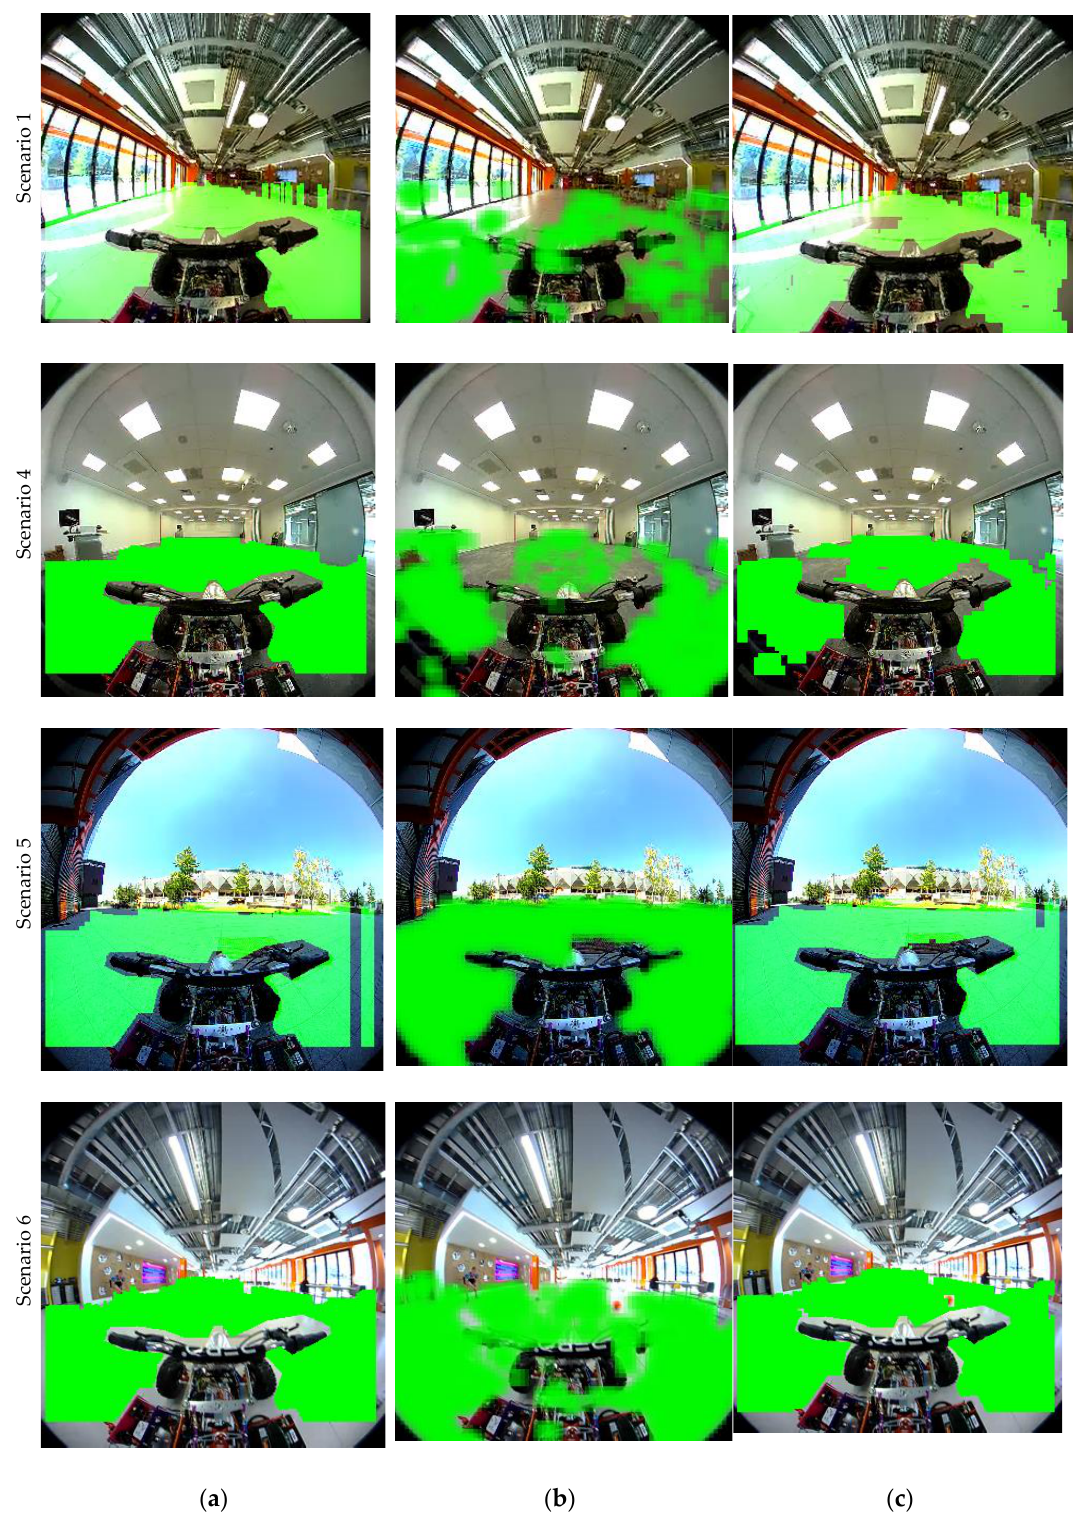
Figure 11. Comparison of free-space maps for different algorithms for three different scenarios. ( a ) LiDAR only; ( b ) Image classifier only; ( c ) Fusion based approach.